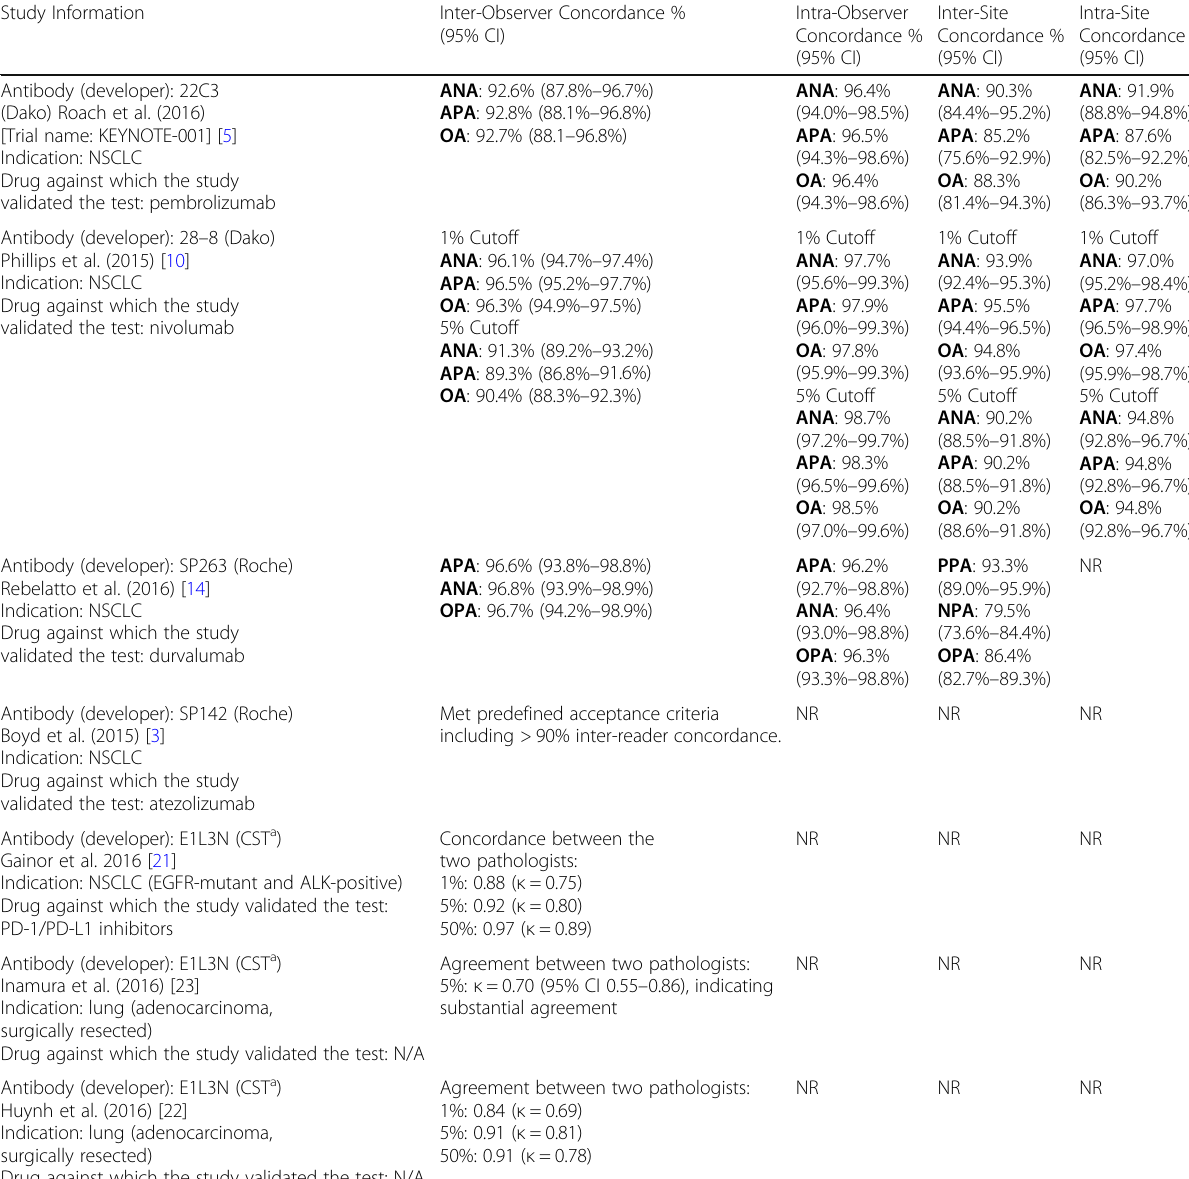
Table 3 Individual Test Performance: Test-Concordance Metrics Study Information Inter-Observer Concordance %